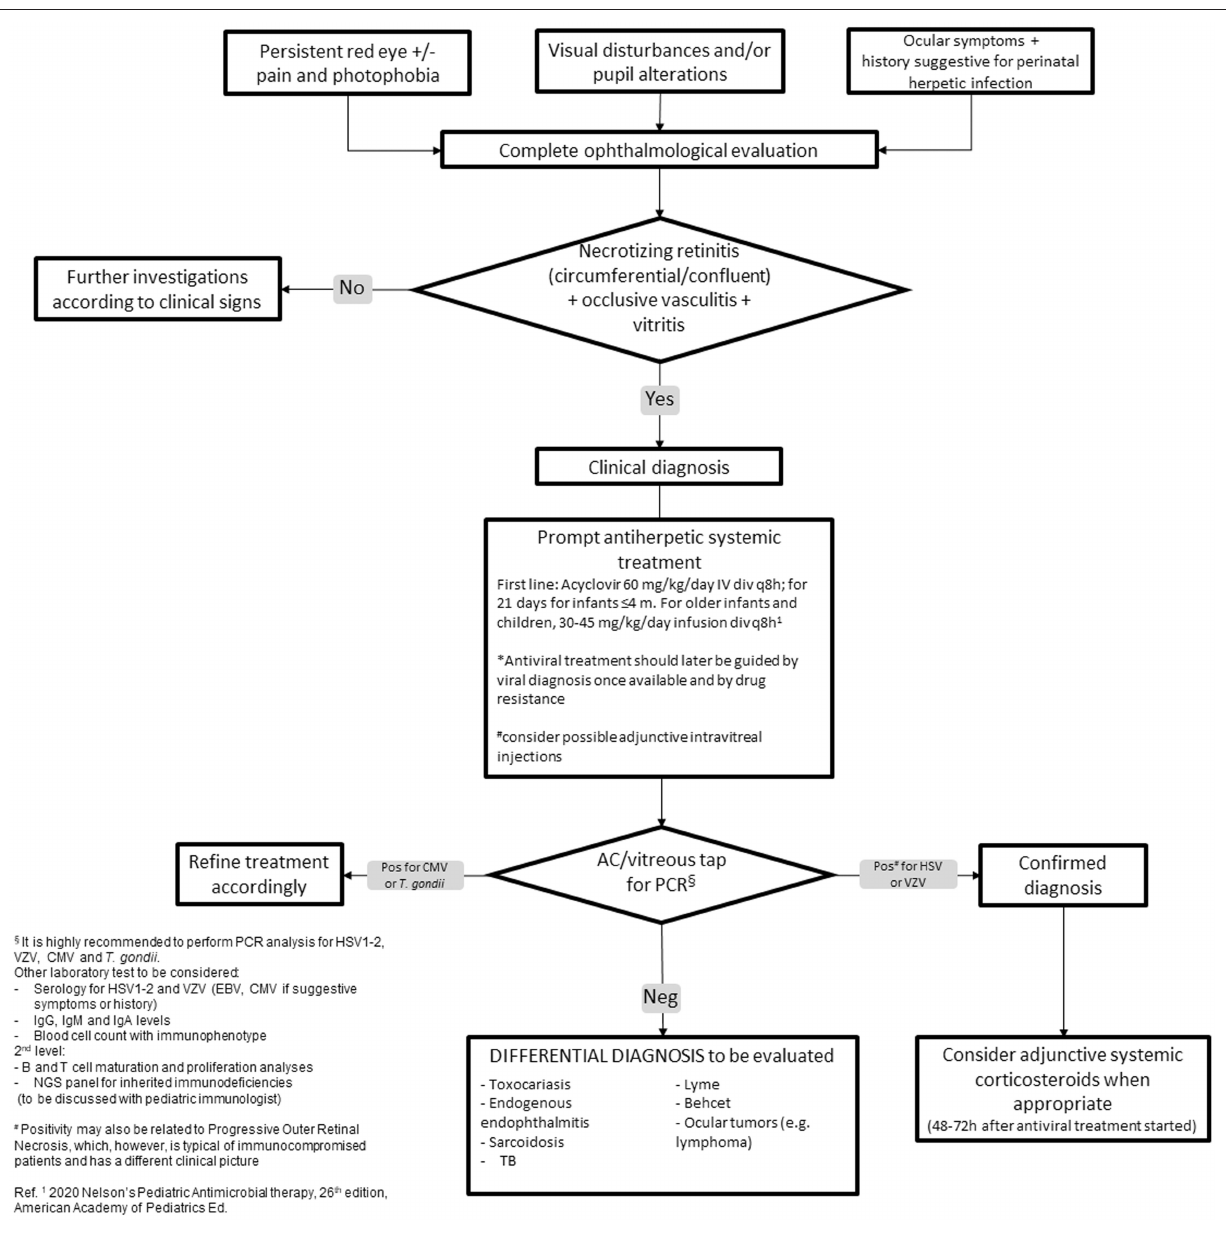
FIGURE 4 | Flow chart summarizing the recommended approach to the patient with suspicion of acute retinal necrosis (ARN). PCR: protein chain reaction; AC: anterior chamber; CMV: cytomegalovirus; HSV1–2: herpes simplex virus 1–2; VZV: varicella-zoster virus; EBV: Epstein–Barr virus; PORN: progressive outer retinal necrosis; TB: